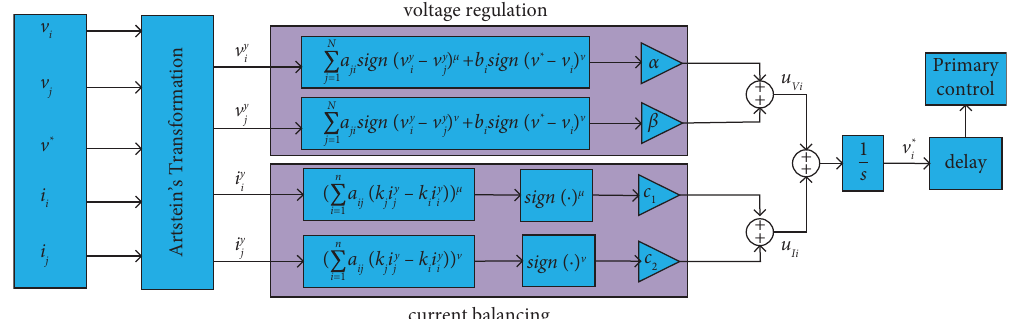
Figure 2: Distributed fx-time secondary